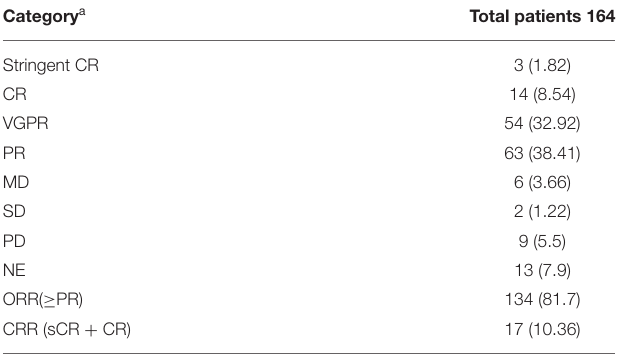
TABLE 2 | Best response to bortezomib plus melphalan-prednisone treatment.